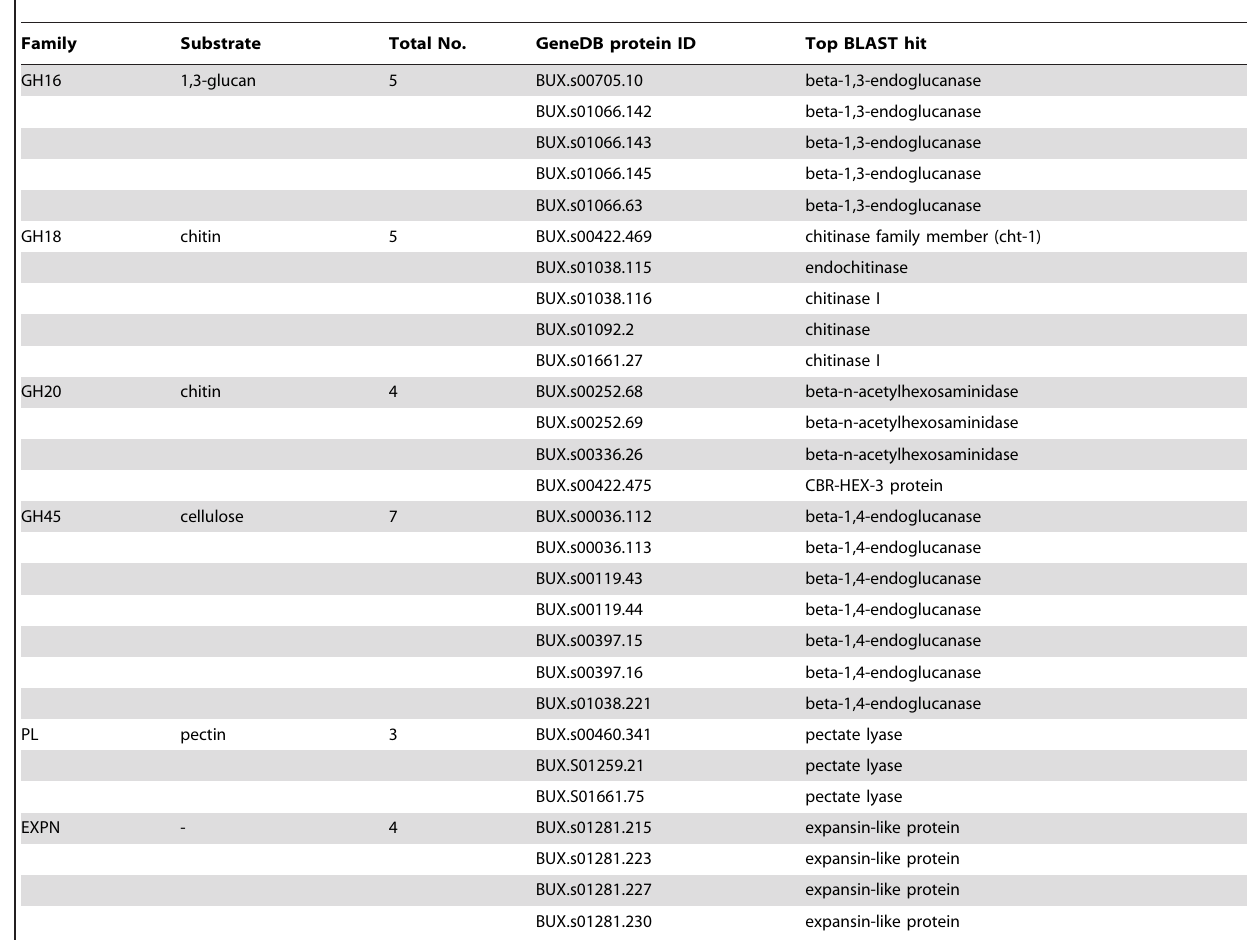
Table 2. Potential plant/fungal cell-wall degrading enzymes in the Bursaphelenchus xylophilus secretome.